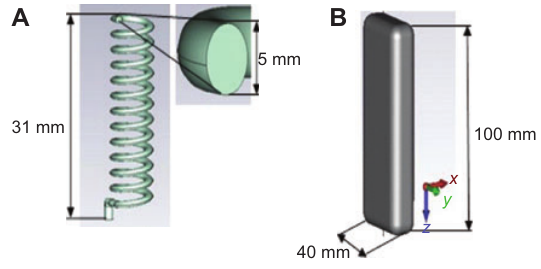
Figure 1 (A) Dimension of the antenna. (B) Dimension of the PEC conducting box.